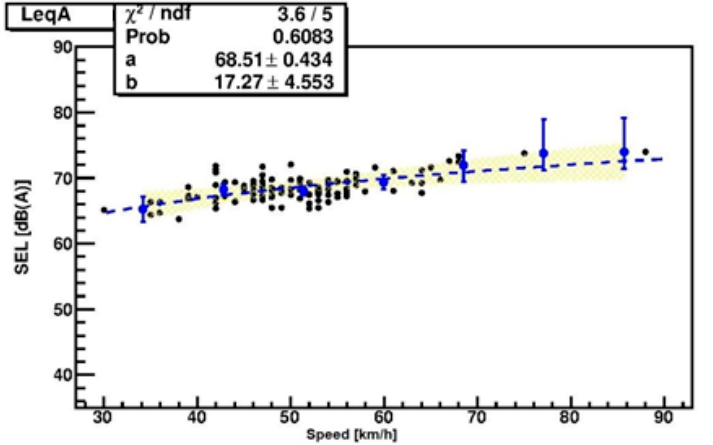
Figure 4. Example of data collected in binning chunks (blue points with error bars) for the best fit between SEL and velocity. The 95% confidence interval from the fit is reported in yellow.